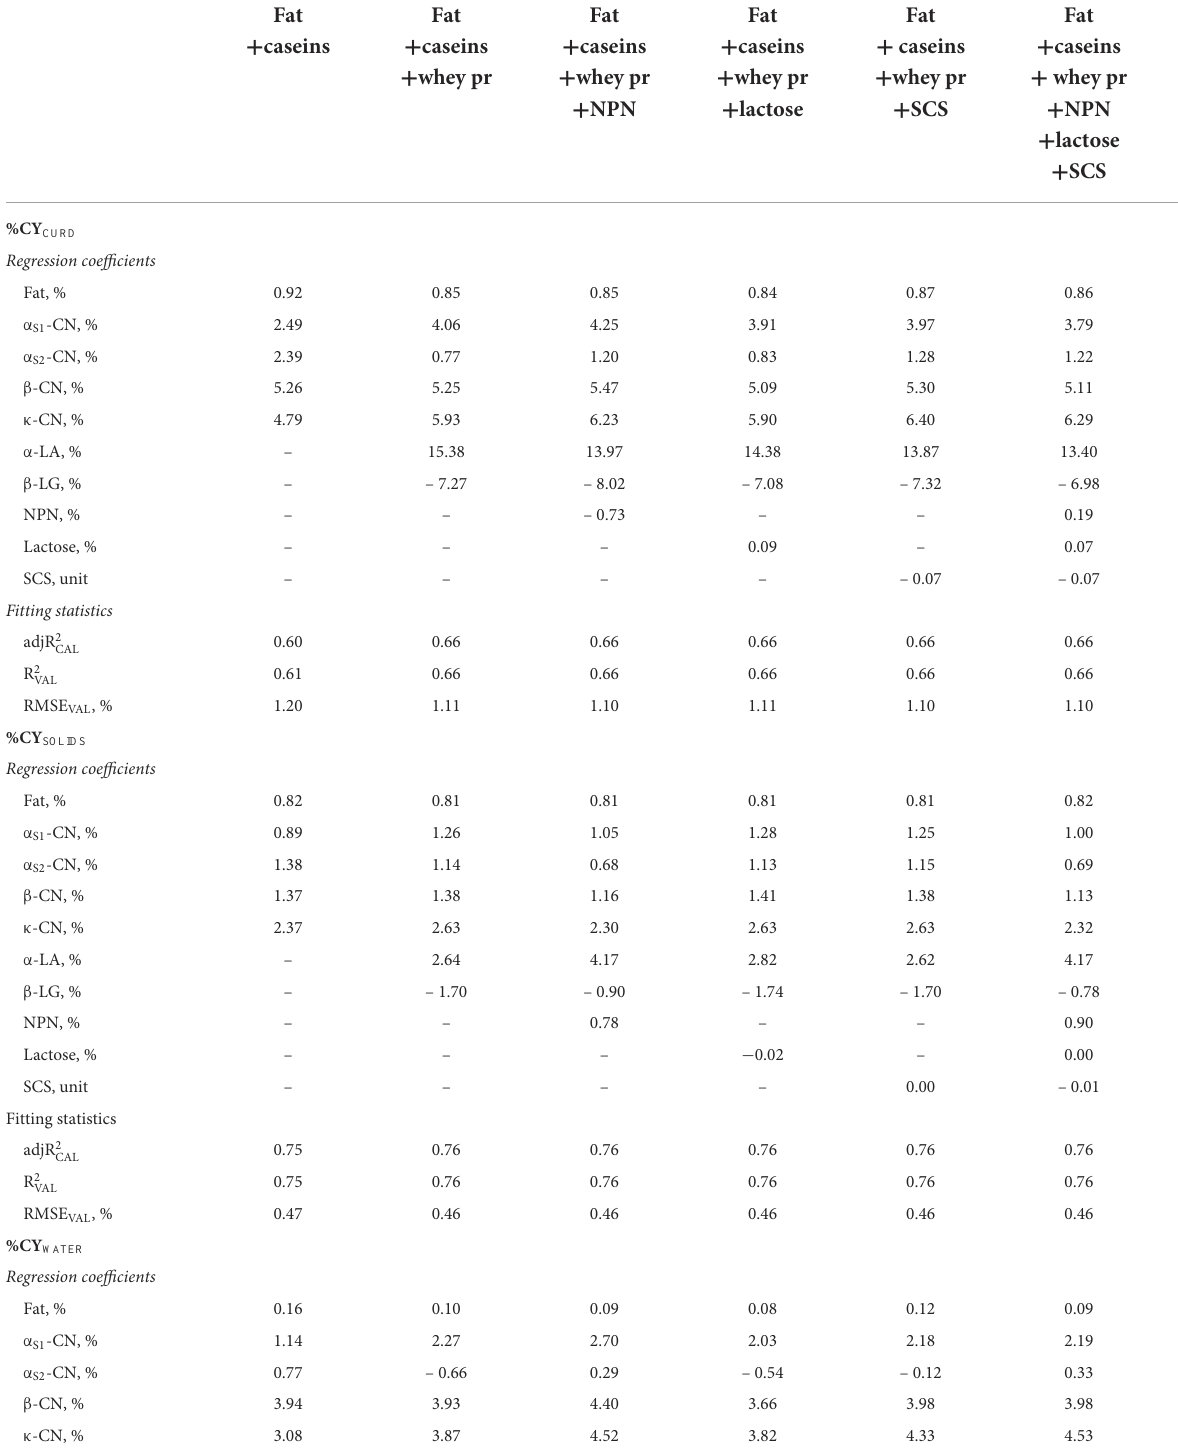
TABLE 4 Regression coefficients and fitting statistics (adjR 2 CAL , R 2 VAL and RMSE VAL ) of predicting fresh cheese (%CY CURD ), ripened cheese (%CY RIPENED ), cheese solids (%CY SOLIDS ) and water retained in fresh cheese (%CY WATER ) of models based on fat, protein fractions and/or non–protein nitrogen (NPN), and/or lactose, and/or somatic cell score (SCS) of processed